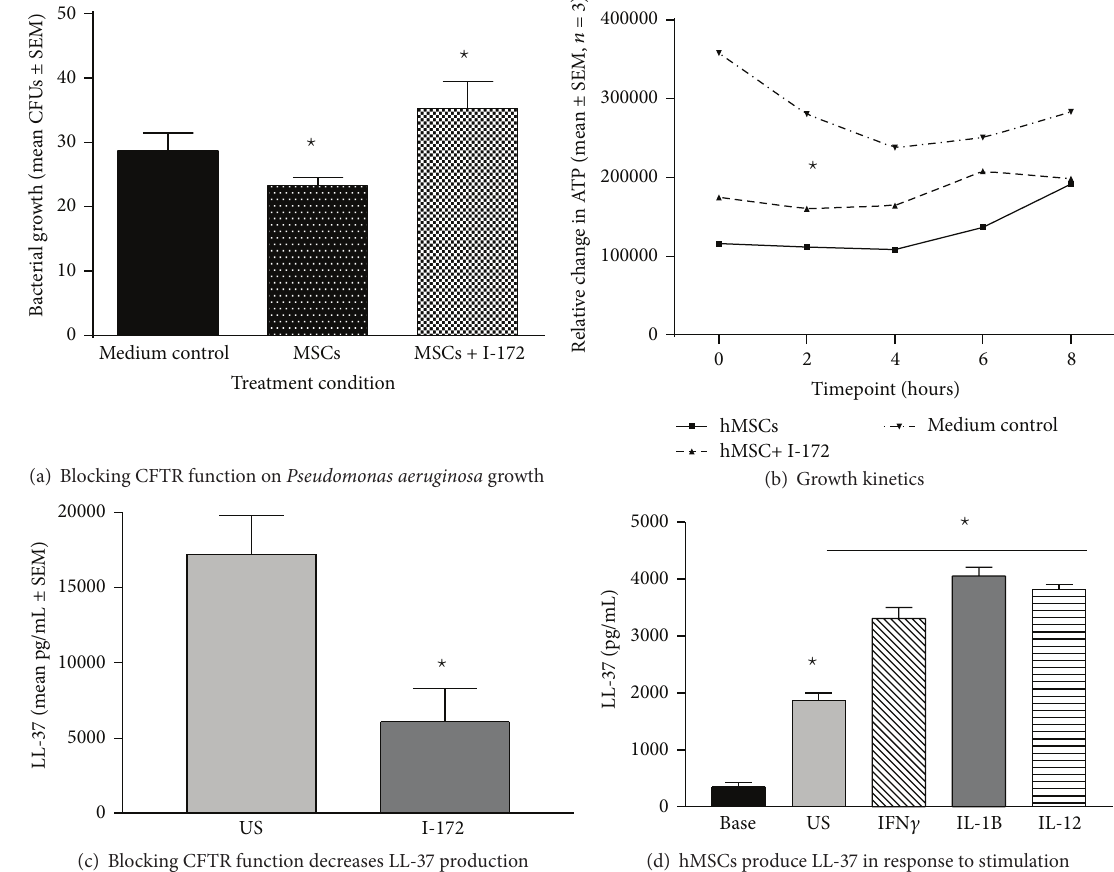
Figure 7: Impact of blocking CFTR function on antimicrobial activity of MSCs. To mimic CF cells, healthy bone marrow derived hMSCs were cultured in the presence and absence of CFTR blocker I-172 (10 𝜇 g/mL) without antibiotics for 24 hours. The hMSC supernatants were evaluated for the ability to impact Pseudomonas aeruginosa PA CFUs (a) and growth rate (b). Supernatants generated from CFTR deficient hMSCs were more inefficient at decreasing Pseudomonas aeruginosa CFUs ((b), 𝑃 ≤ 0.05 ) and growth rate ((c), 𝑃 ≤ 0.05 ) than hMSCs without CFTR activity blocked. Further, hMSCs with deficient CFTR activity had less ability to secrete LL-37 ((c), 𝑃 ≤ 0.05 ) relative to controls. LL-37 production by bone marrow derived hMSCs is decreased when CFTR is blocked but can be increased by treating the cells with a variety of cytokine stimulators. hMSCs stimulated with cytokines IFN 𝛾 (100ng/mL), IL-1B (50 ng/mL), and IL-12 (100ng/mL) secreted significantly more LL-37 than unstimulated controls ((d), 𝑃 ≤ 0.05 , 𝑛 = 4 different hMSC